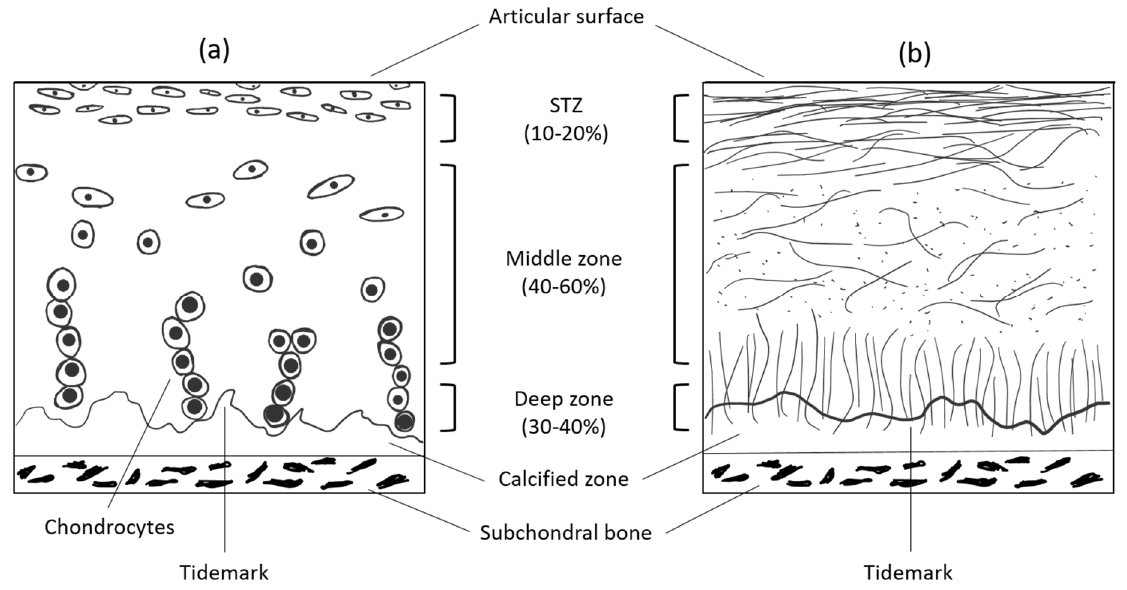
Figure 1. Schematic, cross-sectional diagram of healthy articular cartilage: ( a ) cellular organization in the zones of articular cartilage; ( b ) collagen fiber architecture.